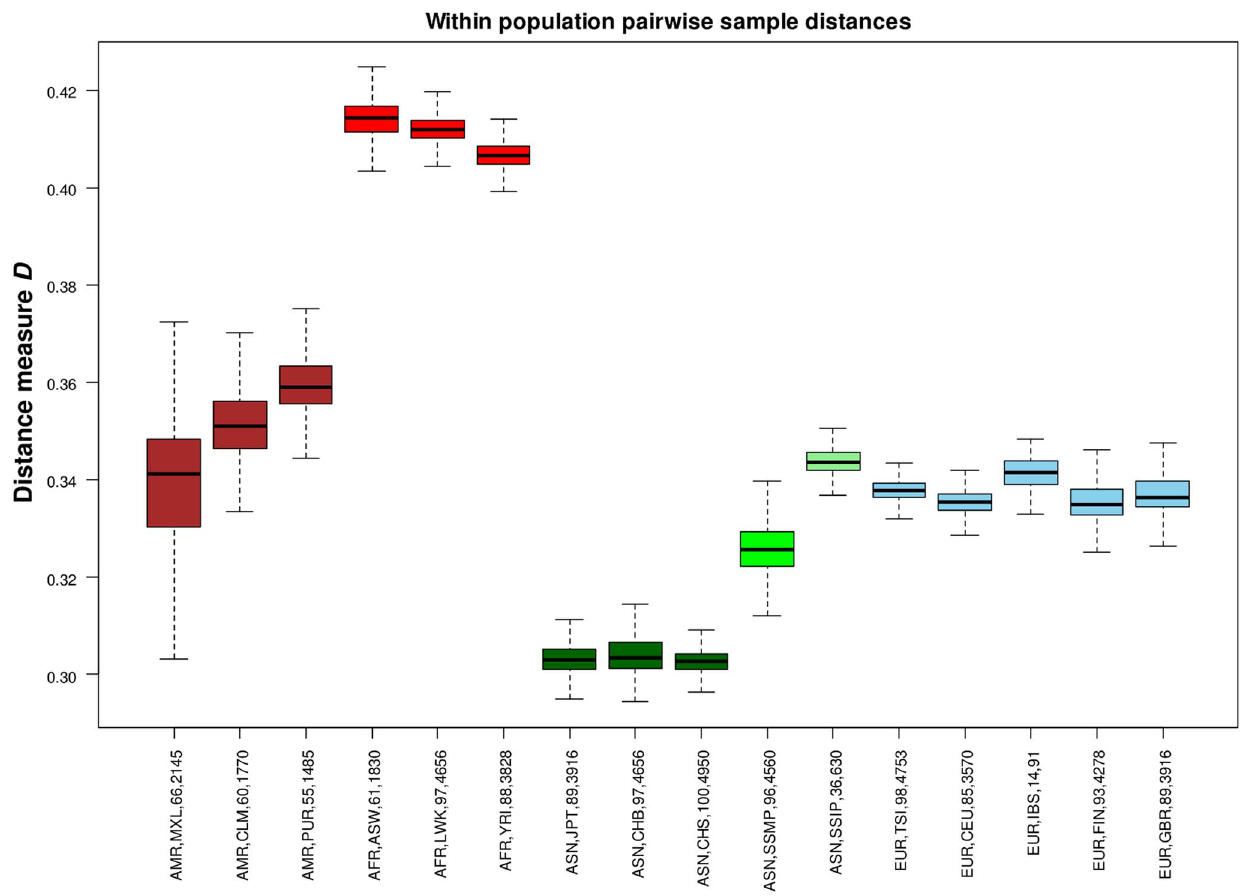
Figure 5. Assessing intra-population diversity between the samples. The extent of SNP sharing between every pair of samples in a population can be measured with a distance measure D that is scaled between 0 and 1 (vertical axis), where a higher value indicates a greater extent